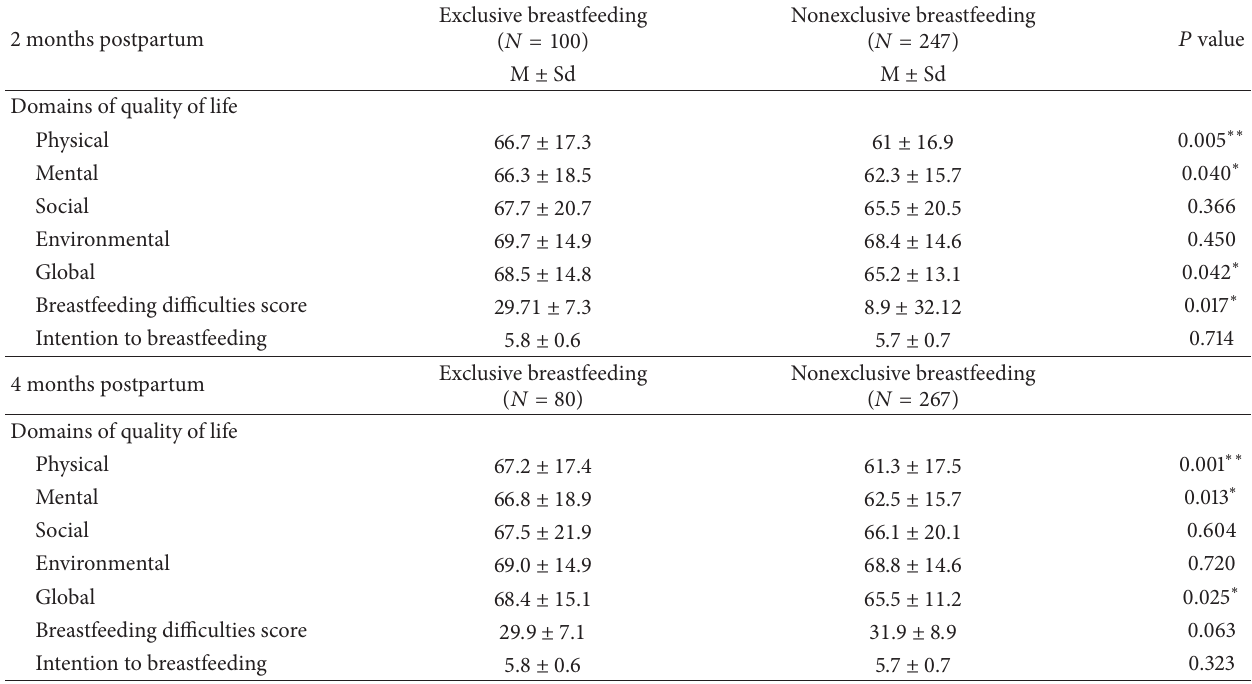
Table 3: Means and standard deviations of the quality of life score, breastfeeding difficulties score, and intention to breastfeeding based on breastfeeding